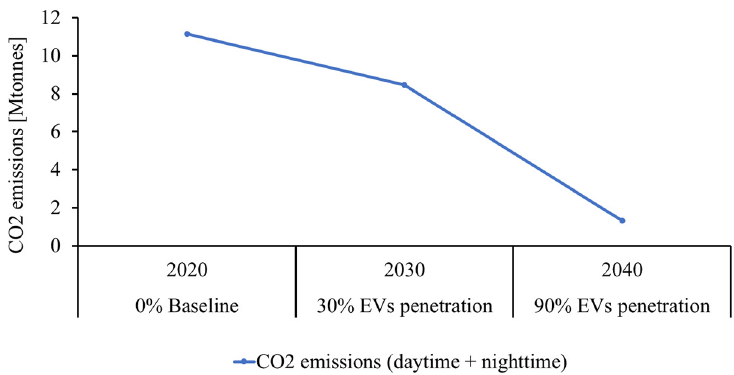
Figure 12. CO 2 emissions’ trend with the EVs penetration over the years.